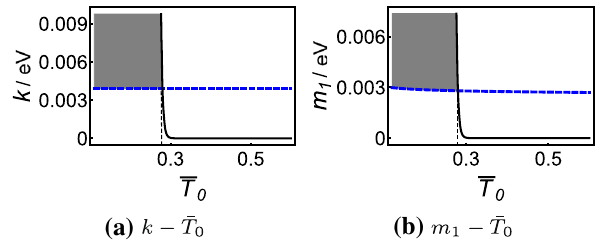
Fig. 15 Thelimitrangeoftheparameter k andthecorrespondingrange of the first resonance mass m 1 . The shadow region of the left panel is the limit range of the parameter k and the shadow region of the right panel is the corresponding range of the first resonance mass m 1 . The black solid lines are the limits for the lifetime of the first resonance to be longer than the age of the universe and the blue dashed lines are limits for 1 / k to be less than 50 µ m